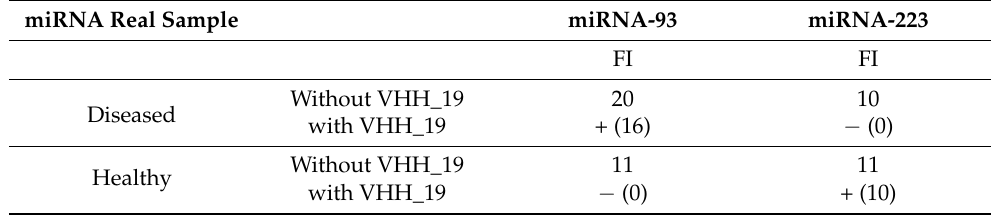
Table A2. Detection of miRNA isolated from human serum with VHH_19 via bead-based assay. FI stands for fluorescence